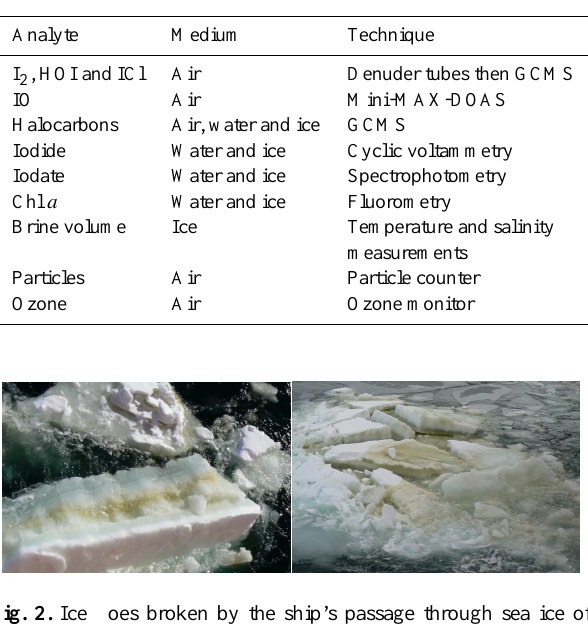
Fig. 2. Ice floes broken by the ship’s passage through sea ice of thickness 0.2 m in the Weddell Sea, where diatom bands are clearly visible about 0.1 m below the surface of the ice.